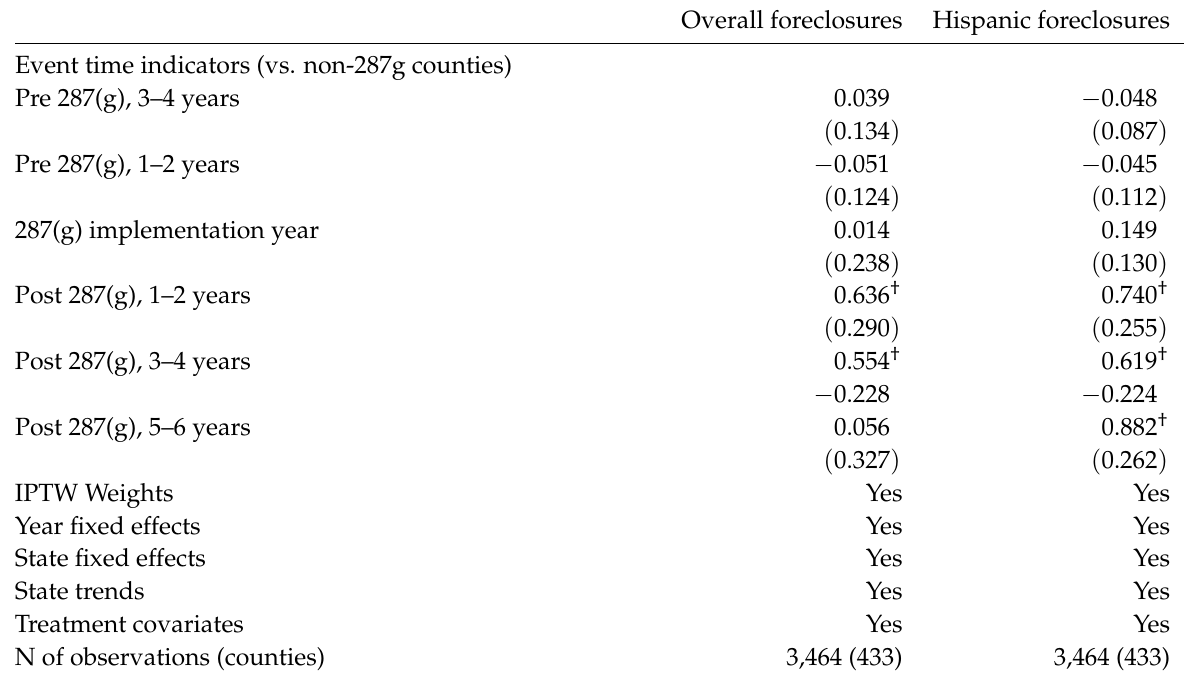
Table 2: Difference-in-difference estimates of 287(g) participation on county foreclosure rates